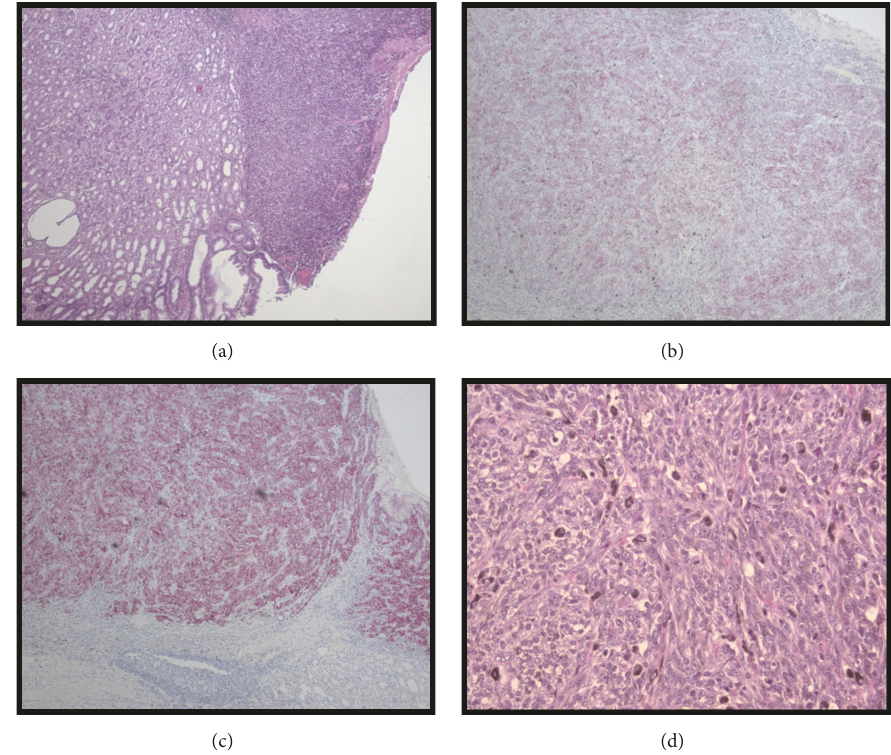
Figure 3: Histological Specimens of Gastric Melanoma. Histological sections of gastrectomy specimen demonstrating primary gastric melanoma. (a) Right side of the image depicts neoplastic cells that do not invade past the submucosa that still retains normal gastric architecture (H&E x100). (b) Primary gastric melanoma positive stain for Melanin A (H&E x100). (c) Primary gastric melanoma positive stain for HMB-45 (H&E x100). (d) Malignant melanocytic neoplasm producing brown melanin pigment with a cherry red nucleoli and mitotic figures (H&E x